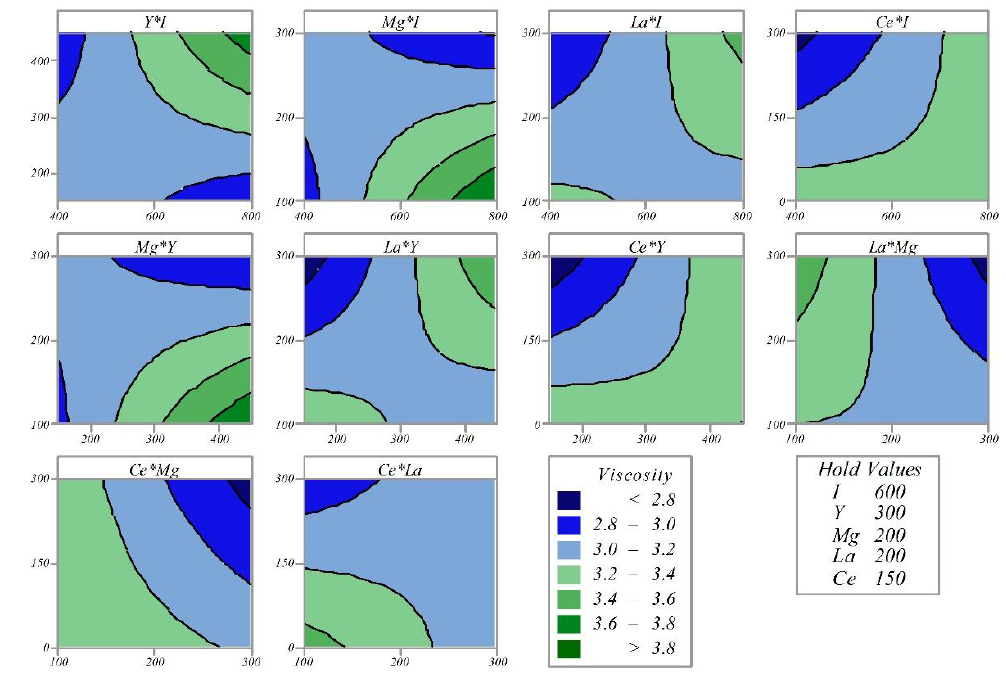
Fig. 6 . Contour plot of